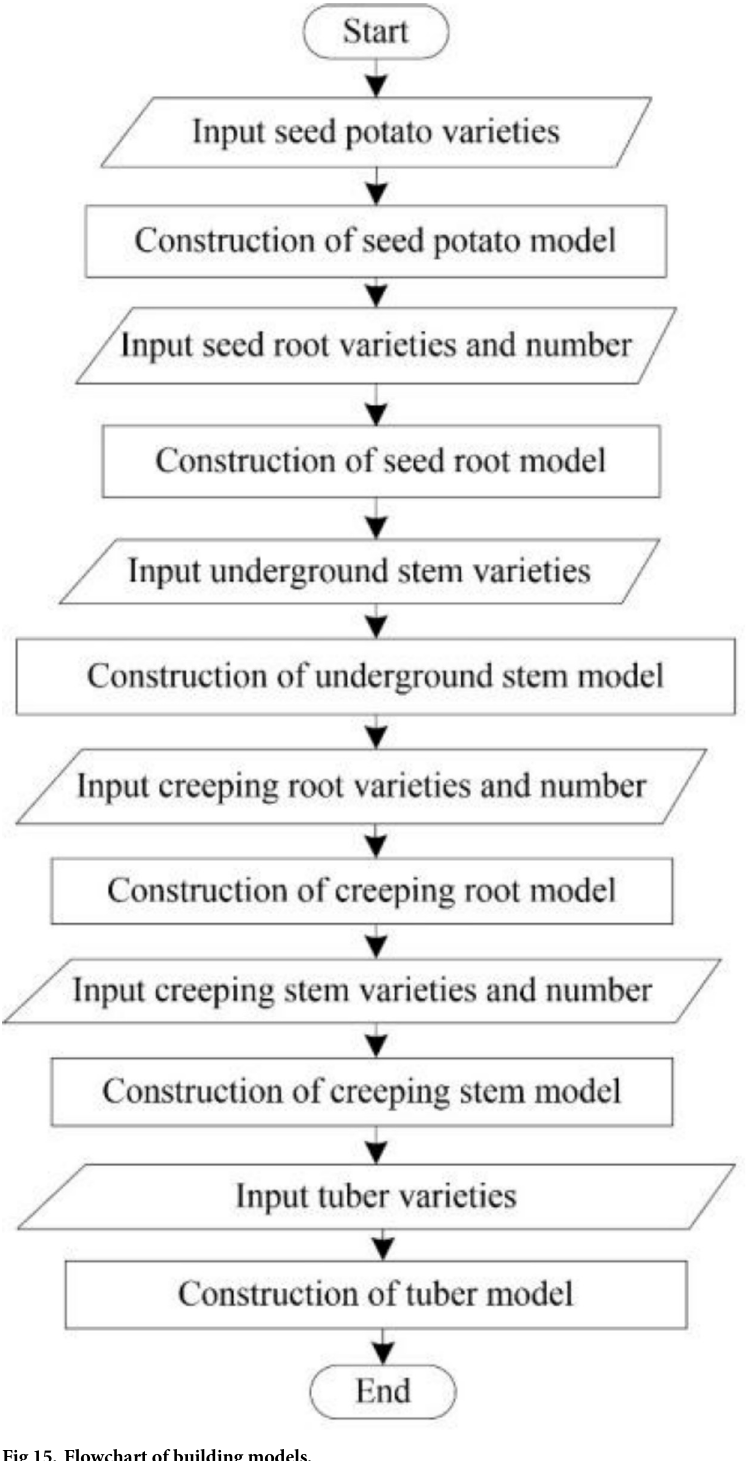
Fig 15. Flowchart of building